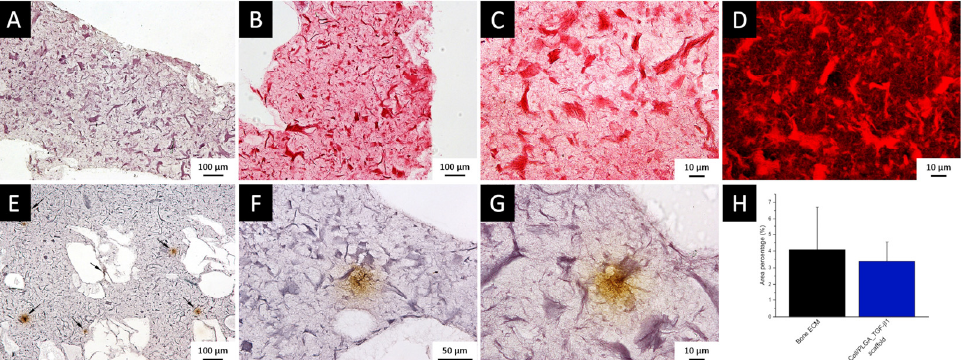
Figure 7. Histological staining in 3D-printed scaffolds ( A – D ): ( A ) Haematoxylin and Eosin staining; ( B – D ) Sirius Red staining underlining collagen fibres observed by brightfield microscope ( B , C ) and fluorescence microscope ( D ) (( A , B ) 10 × magnification; ( C , D ) 40 × magnification). TGF- β 1 staining in 3D-printed scaffold and semi-quantitative analysis ( E – H ): TGF- β 1 staining representing PLGA_ TGF- β 1 NPs inclusion in the scaffold structure at different magnification: 10 × ( E ); 20 × ( F ); 40 × ( G ); ( E ) black arrows highlight the protein accumulation inside PLGA_TGF- β 1 NPs throughout the collagen-based scaffold. ( H ) Histogram representing area percentage of TGF- β 1 staining in 3D-printed scaffold measured by semi-quantitative